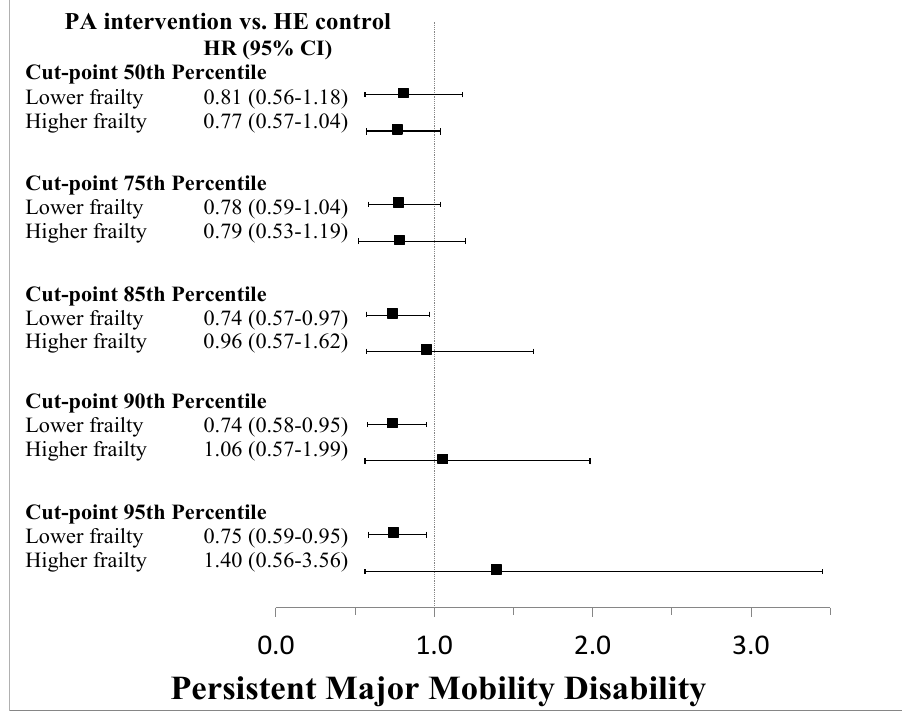
Figure 7. Cox proportional hazards regression results testing frailty index cut-points as strata to identify subgroups in which the intervention was no longer effective in preventing persistent major mobility disability.